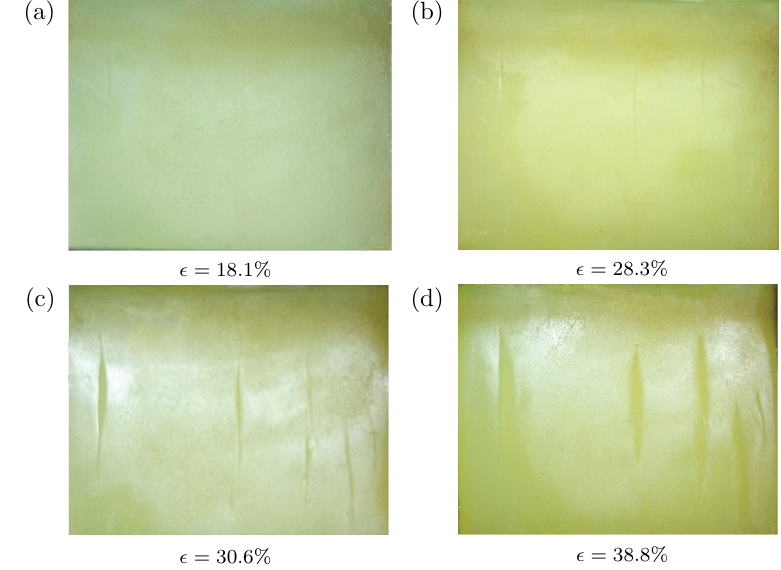
Figure 4. Surface morphology of a cuboid silicone rubber under different levels of compressive strains: ( a ) 18.1%; ( b ) 28.3%; ( c ) 30.6%; ( d ) 38.8%. The specimens experience cyclic loadings before the uniaxial